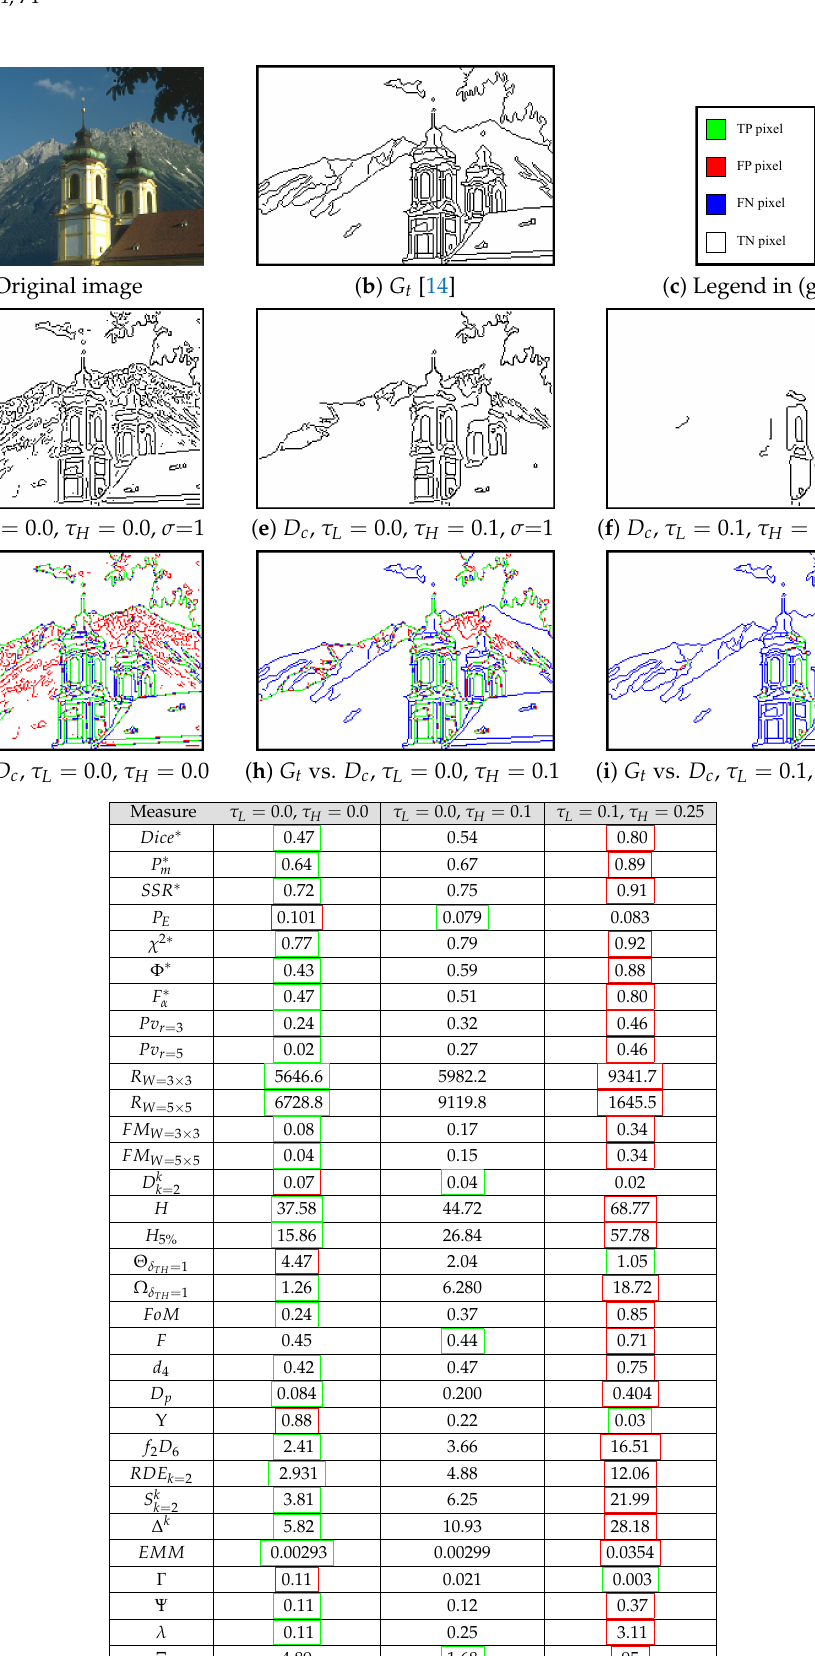
Figure 11. Evaluation measure results for a real image segmented [4] at different hysteresis